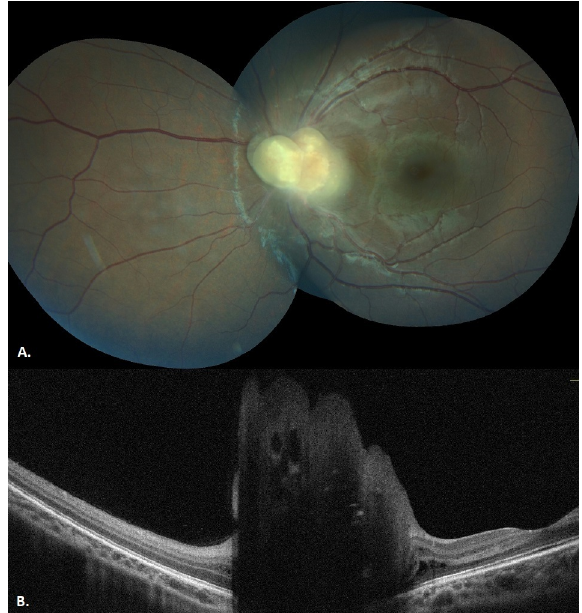
Figure 2: A) Fundus image of the left eye after a six-year follow-up shows a minimal change. B) Optical coherence tomography image of the left eye after six-year follow-up shows intratumoral cystic spaces and acoustic shadowing due to the